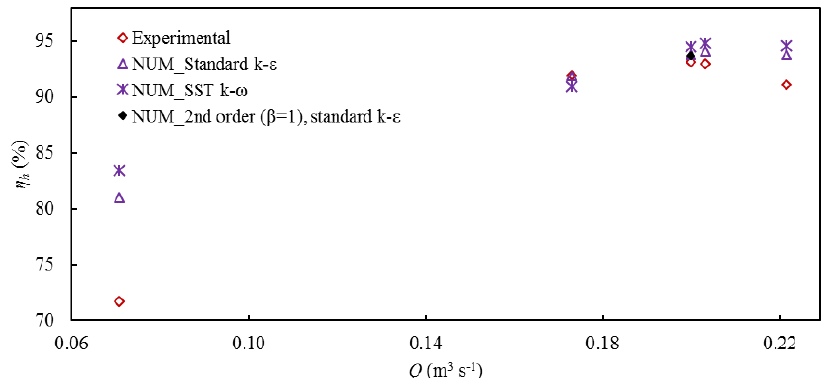
Figure 4. Comparison between experimental and numerical hydraulic efficiencies at five operating points, showing the performance of the numerical model at different operating conditions for the model Francis turbine; Q = 0.2 m 3 ∙ s − 1 is discharge at BEP. NUM corresponds to numerical data.